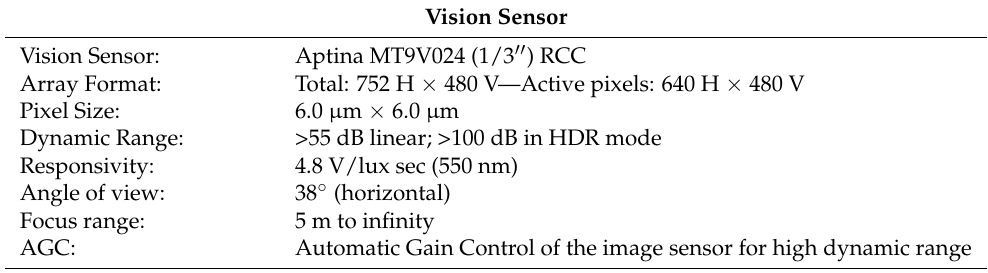
Table 1. Basic technical specification of the used Mobileye system.